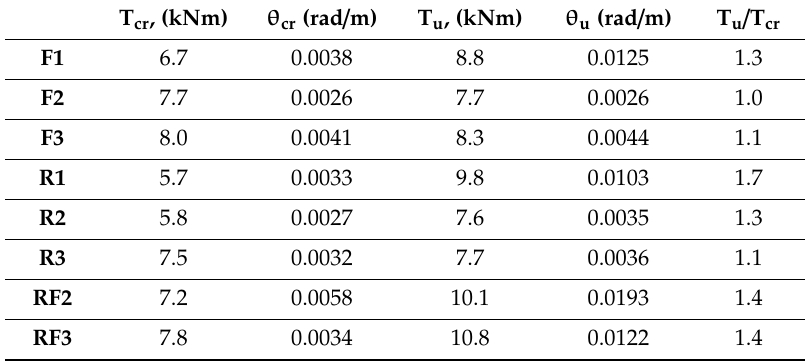
Table 5. Experimental results from each beam tested under torsional